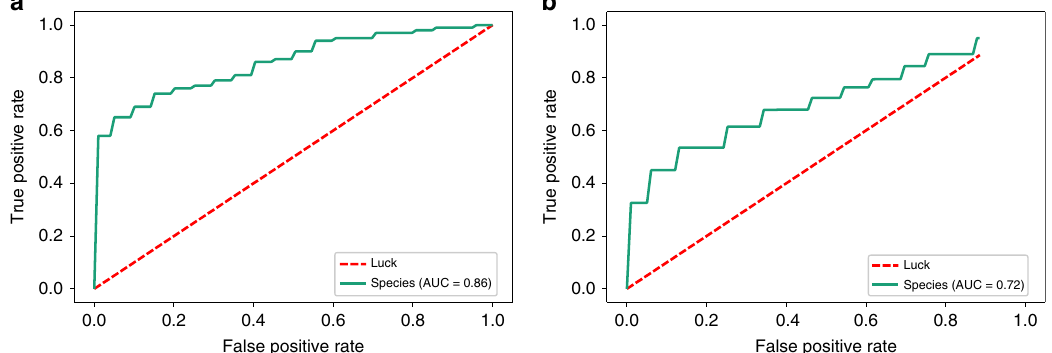
Fig. 3 Gut microbial species differentiate UIA patients from controls. a Receiver operating curve (ROC, turquoise) according to cross-validated random forest models on 47 species for the training set (the fi rst cohort, controls, n = 100; UIA patients, n = 100). The area under the receiver operating curve (AUC) is 0.86, and the 95% con fi dence interval (CI) is 0.81 – 0.91. b ROC for the test set (the second cohort, controls, n = 40; UIA patients, n = 40). The AUC is 0.72, and the 95% CI is 0.65 –